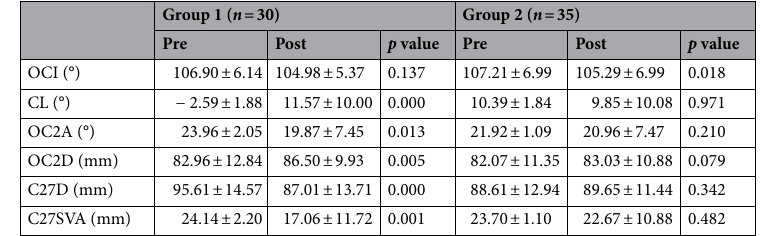
Table 5. Change of cervical sagittal parameters by group. All values are in mean ± standard deviation. OCI, occipitocervical inclination; CL, cervical lordosis; OC2A, occiput-C2 angle; OC2D, occiput-C2 spinous process distance; C27D, C2-C7 interspinous process distance; C27SVA, C2-C7 sagittal vertical axis. p value below 0.05 indicates statistically significant difference between preoperative and postoperative